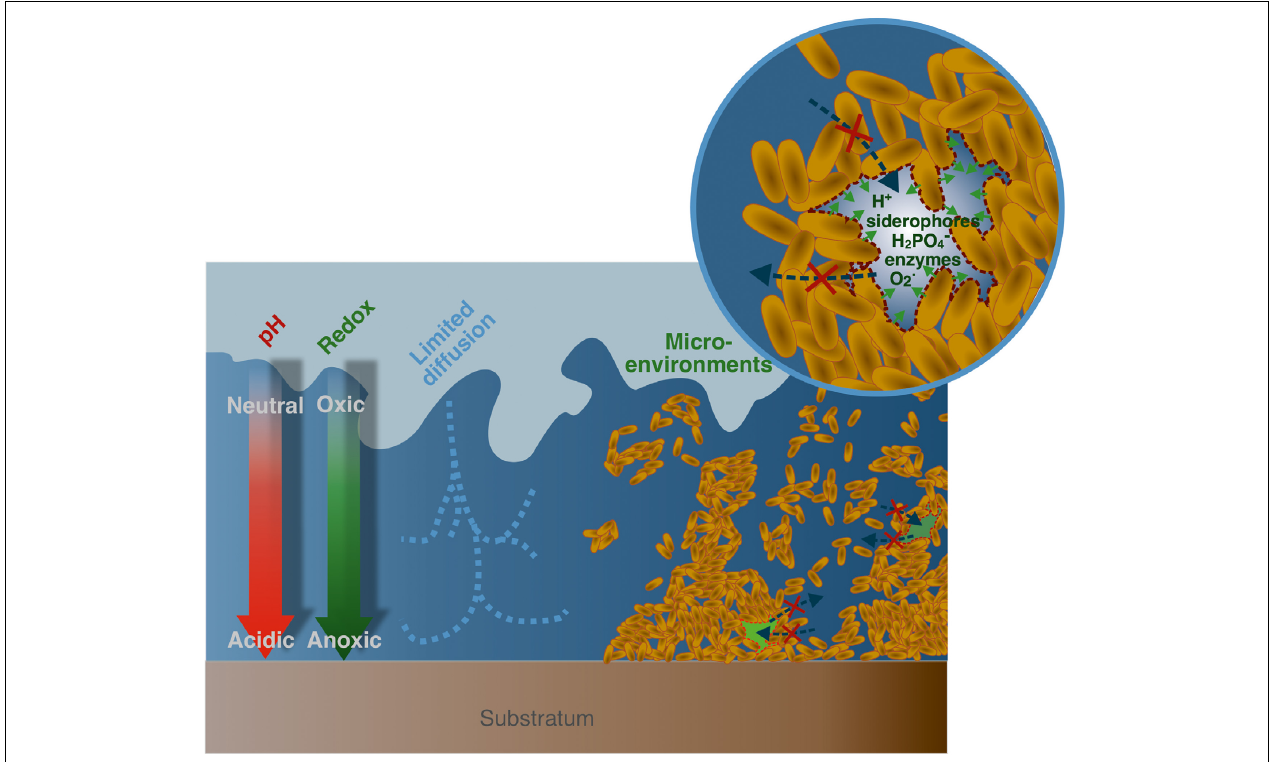
FIGURE 1 | Physico-chemical properties of microbial biofilms. From left to right, existence of gradients in pH and redox conditions with depth; diffusion limited transport of nutriments, molecules (such as siderophores, enzymes), and metabolites; existence of microenvironments within the biofilm thickness that exhibit specific physico-chemical conditions (for instance low pH, high siderophore, superoxide, enzymes, or phosphate concentrations) at the local